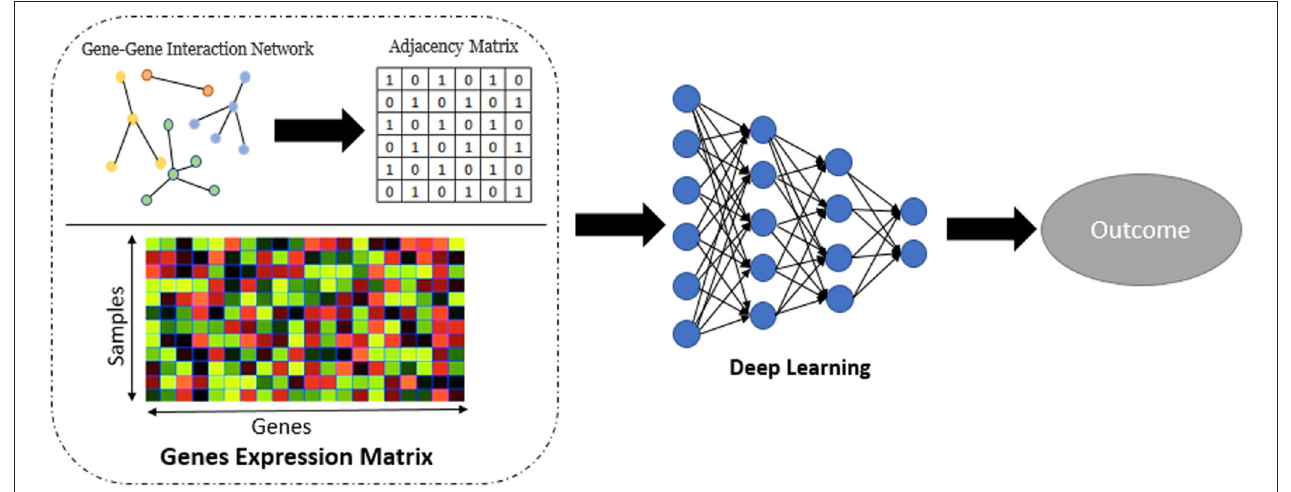
FIGURE 2 | Workflow for the network embedding of gene